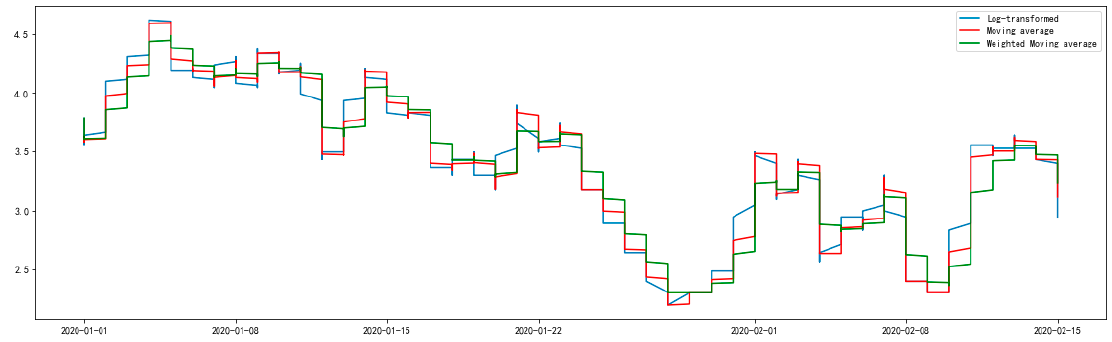
Figure 1. The log-transformed, moving average and weighted moving average of NO 2 concentration datasets.